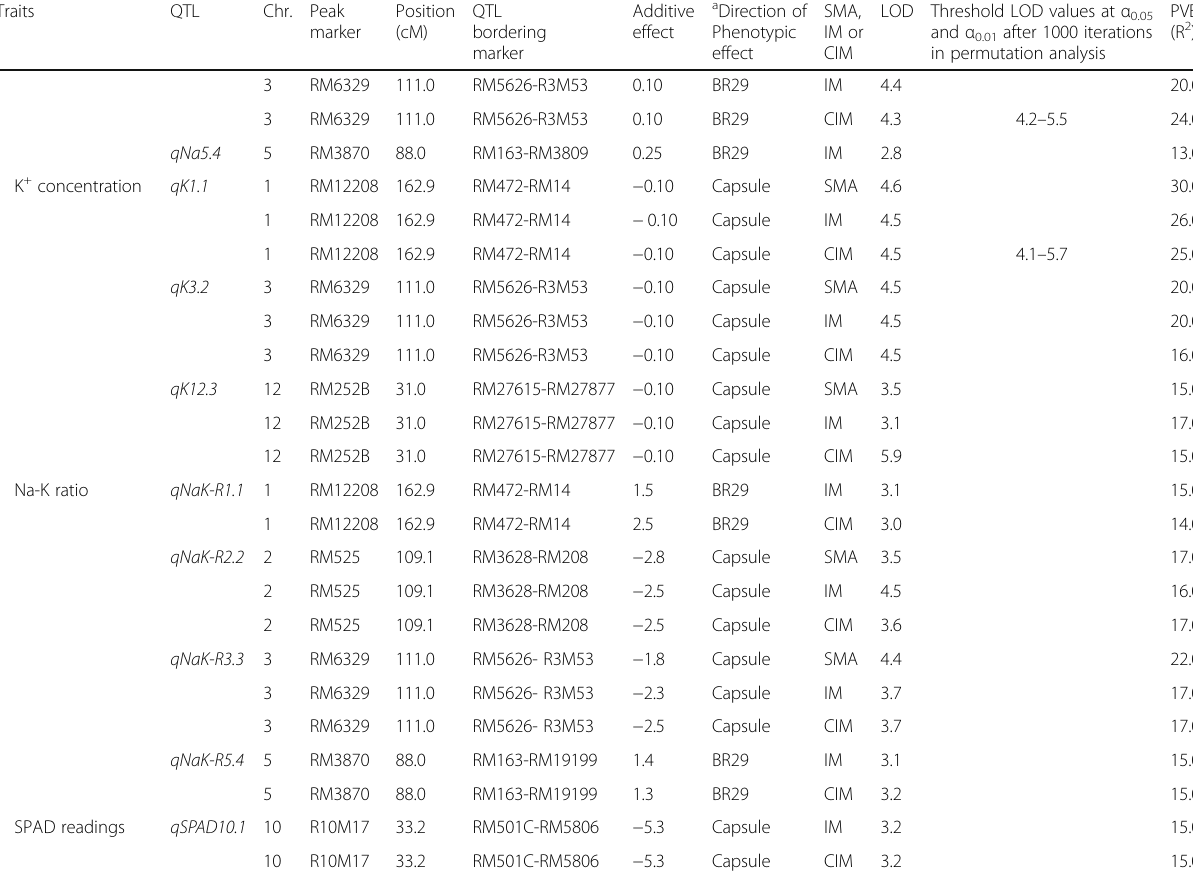
Table 3 QTL detected for salt tolerance-related traits viz. overall phenotypic performance (SES), survival, physiological and agronomic traits during seedling stage based on single-marker analysis (SMA), interval mapping (IM) and composite interval mapping (CIM) in the Capsule/BR29 F 2:3 population